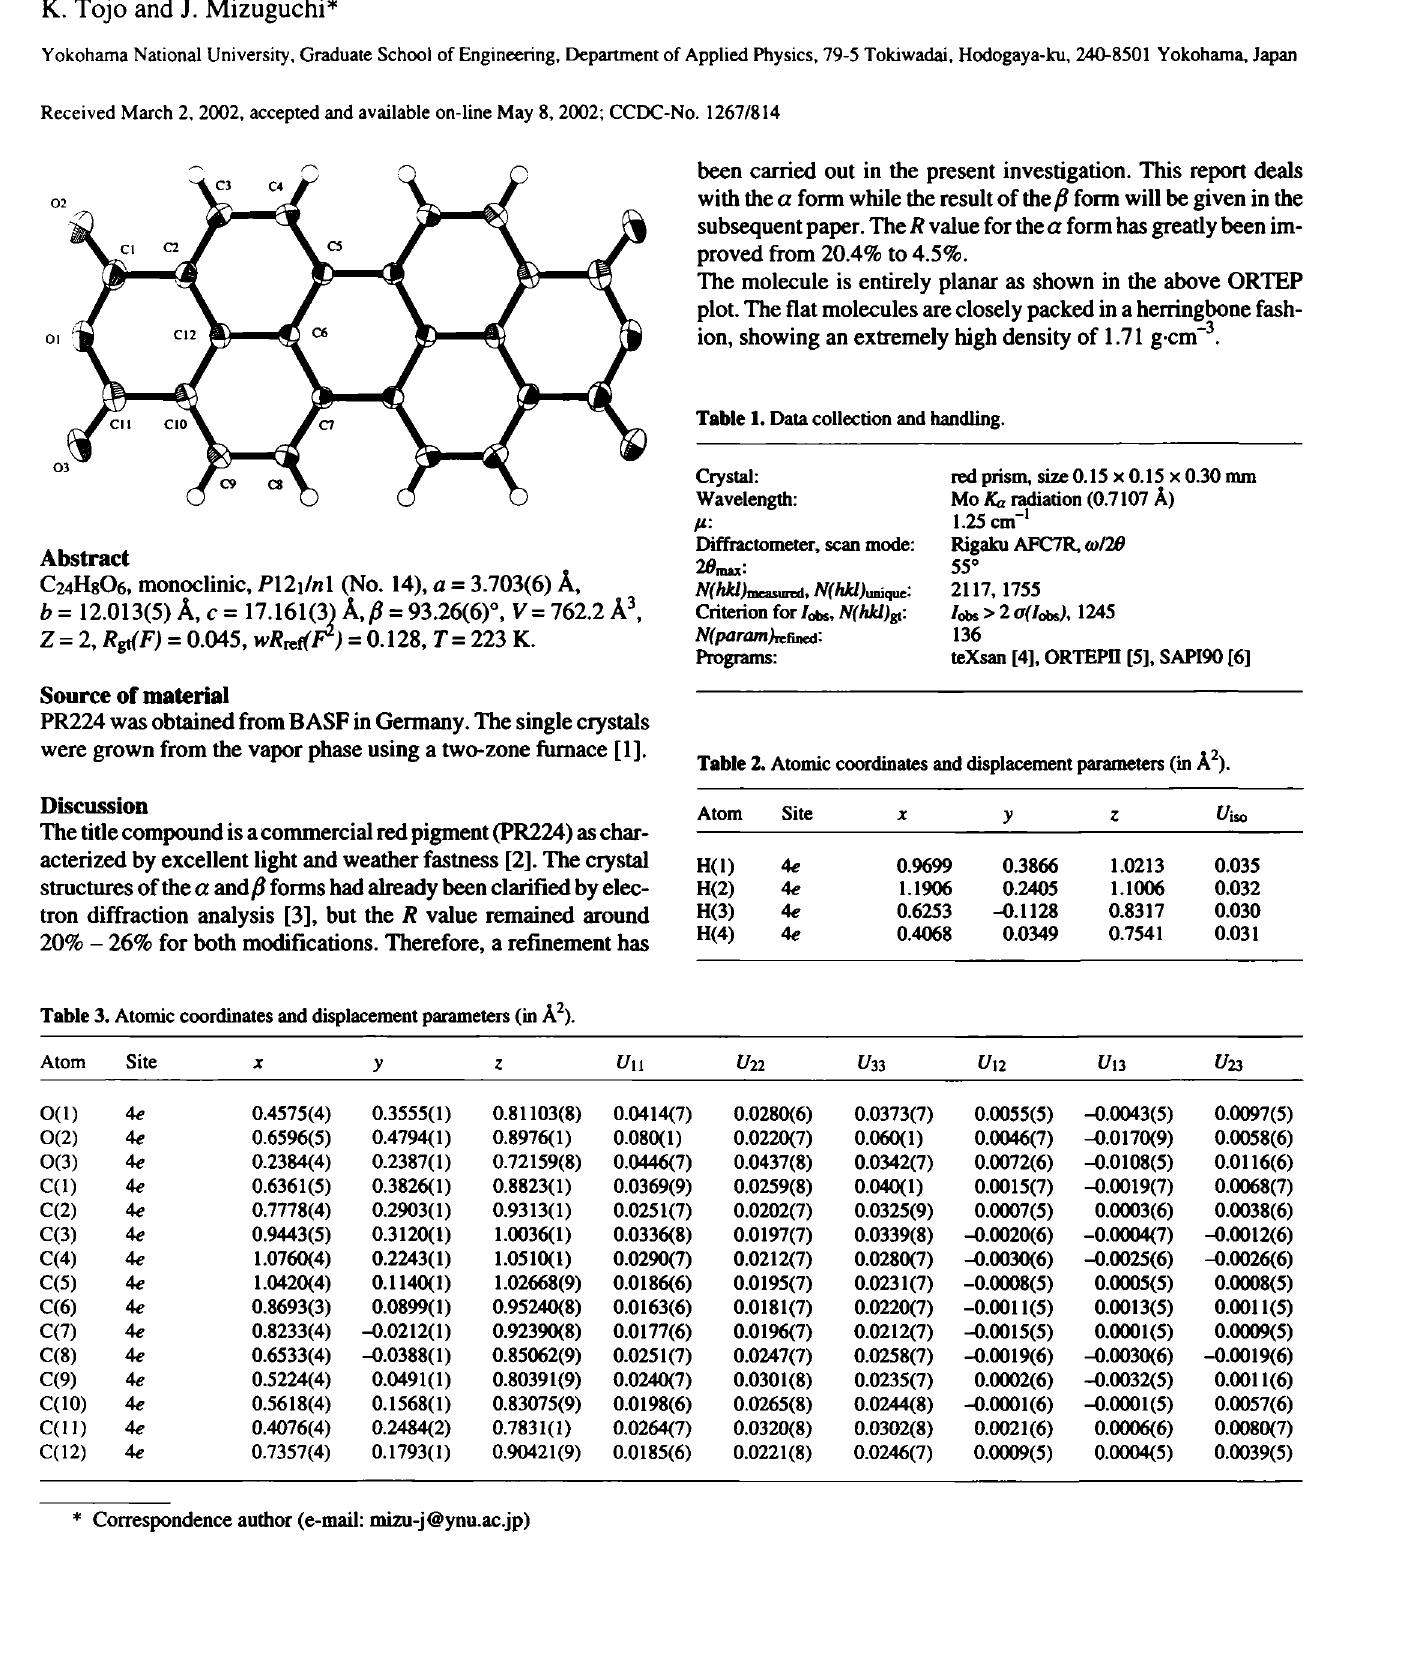
Rigaku AFC7R, a>/20